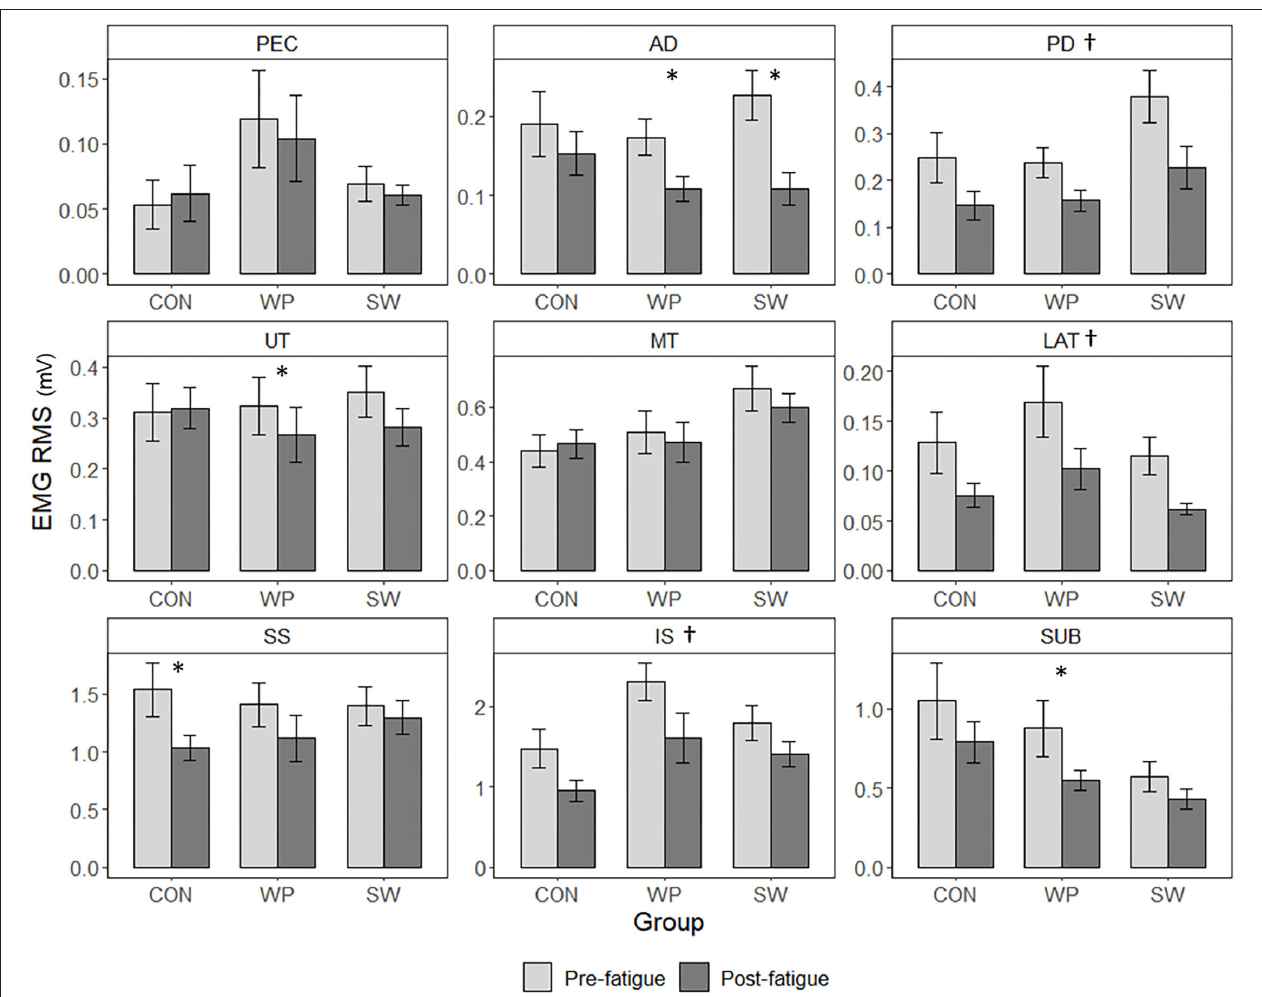
FIGURE 5 | EMG RMS of water polo athletes (WP), swimmers (SW), and a control group (CON) were measured during maximal concentric external and internal shoulder rotations performed before and after a concentric shoulder internal rotation fatigue protocol. Values are estimated marginal means ± SE measured for pectoralis major (PEC), anterior deltoid (AD), posterior deltoid (PD), upper trapezius (UT), middle trapezius (MT), latissimus dorsi (LAT), supraspinatus (SS), infraspinatus (IS), and subscapularis (SUB). † Indicates a significant interaction of Muscle × Condition, with decreased RMS values after the fatigue protocol ( p < 0.05). *Indicates a significant group-specific decrease in RMS ( p <